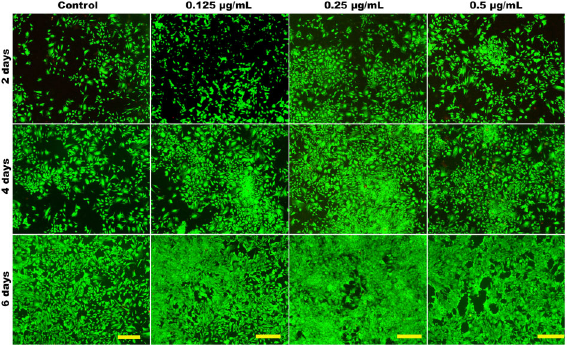
Figure 8. Immunohistochemical staining revealed the presence of type II collagen. Chondrocytes cultured in vitro with 0 (control), 0.125, 0.25, and 0.5 mg/mL JJYMD-C for 2, 4, and 6 days. Scale bar: 100